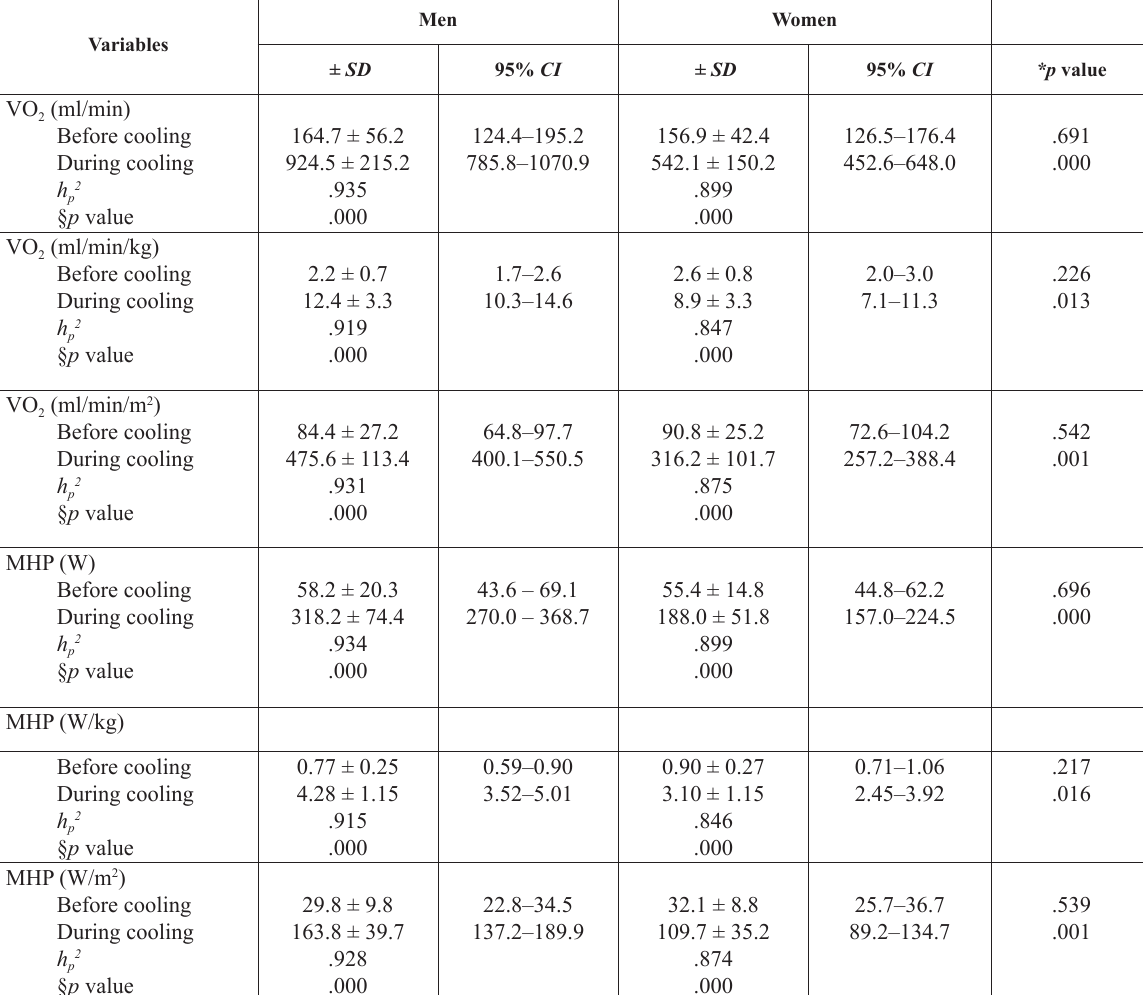
Table 3. Oxygen consumption (VO